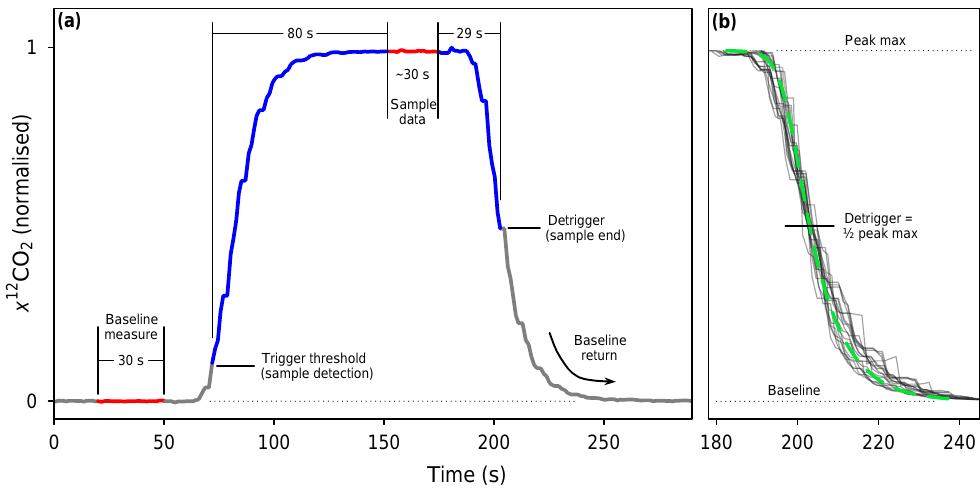
Figure 3. (a) Example of raw G2131-i measurement data and breakdown of events during analysis of a 50mL syringe sample. Blue segments are truncated from the sample peak by our software script while red segments are the extracted measurement data. All timings and thresholds are user customisable in the software for variation in sample size and equipment. (b) The most reliable sample end time (detrigger) was established as the point when measurements returned to half the difference between peak-maximum (or minimum in the case of samples with lower x CO 2 than reference air) and the baseline value. Grey lines are amplitude-normalised tailing segments from 23 test samples widely varying in x 12 CO 2 . The broken green curve denotes a generalised logistic function fit to these test data by non-linear least squares optimisation. Solving the fitted function determined that 29 ± 2s elapsed between peak-maximum and half-maximum irrespective of sample